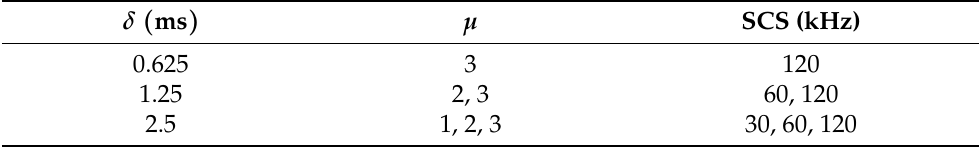
Table 2. Supported transmission numerologies and period of UL/DL